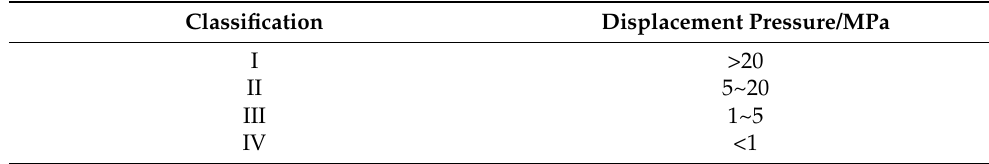
Table 4. Displacement pressure classification of gas storage caprock of depleted oil and gas reservoir.